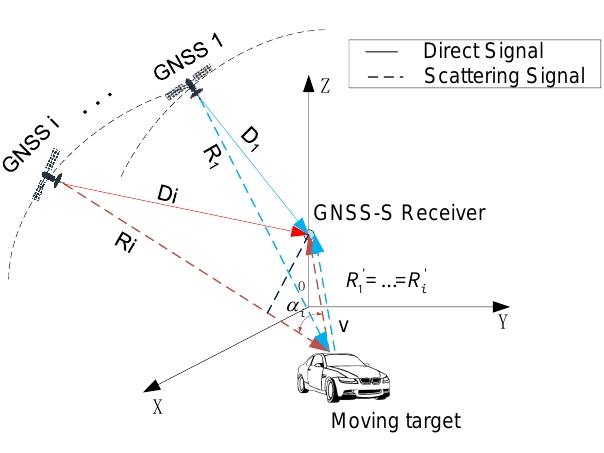
Figure 2. System Geometry.